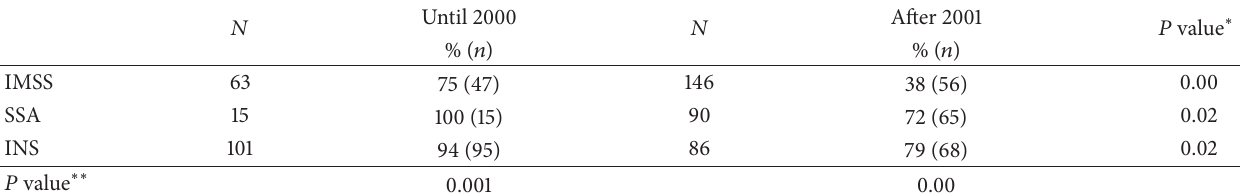
Table 1: Percentage of adequate initial antiretroviral prescriptions according to prevailing guidelines.